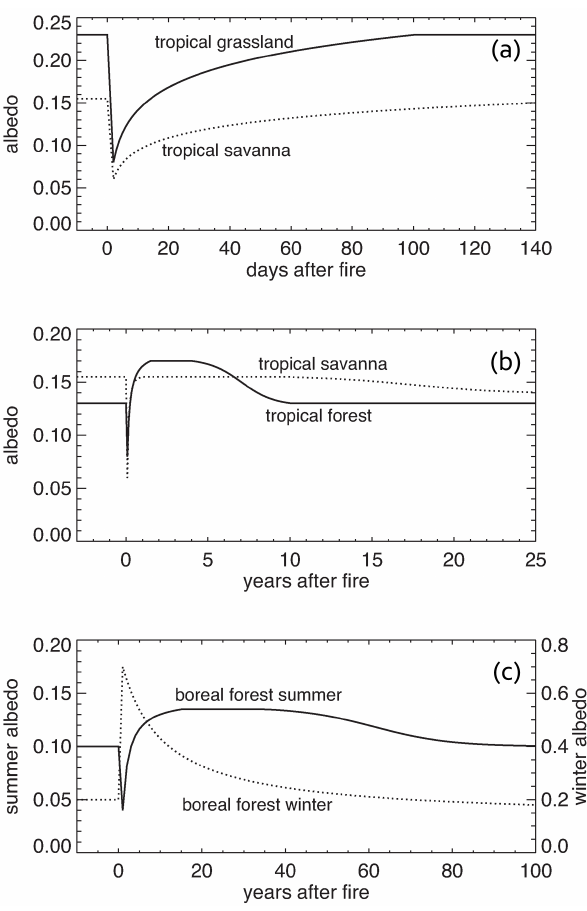
Fig. B1. Timeseries of surface albedo, estimated from past research, showing the recovery of different biomes from fire disturbance. Note the different timescales for (a) and (b) and the different y-axis values for the winter and summer fires in (c) . These estimates were compiled from the following literature for tropical grasslands a , tropical savanna b , tropical forests c , and boreal forests d . a Fisch et al., 1994; Fuller and Ottke, 2002; Jin and Roy, 2005; White and Loftin, 2000. b Beringer et al., 2003; Brookan-Amissah et al., 1980; Govaerts et al., 2002; Higgins et al., 2007; Jin and Roy, 2005; Myhre et al., 2005. c Culf et al., 1995; Giambelluca et al., 1997; Pinker et al., 1980. d Amiro et al., 2006; Lyons et al., 2008; McMillan et al., 2008.